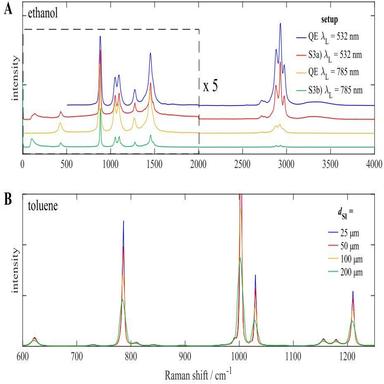
A) Raman spectra of pure ethanol recorded with different setups (for details of S3a) and S3b) see material section; QE: Ocean Insight QE spectrometer with fiber-based Raman probe). For a better visibility, the intensities in the lower and fingerprint regions are scaled by a factor of 5. B) Raman spectra of pure toluene recorded with different slit widths (setup S3b)).